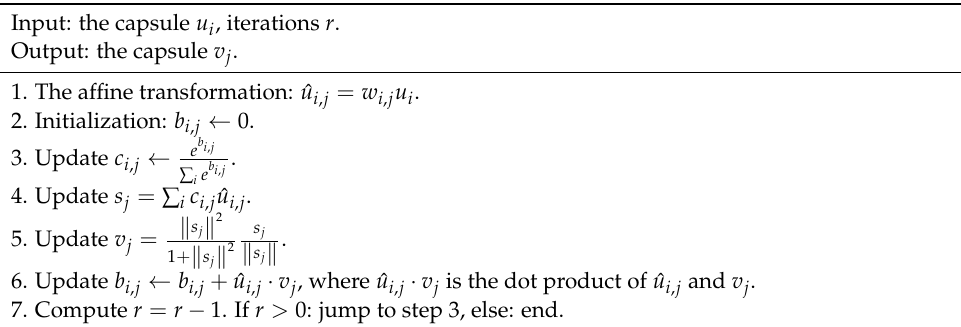
Table 1. Algorithm of dynamic routing in capsule layer.